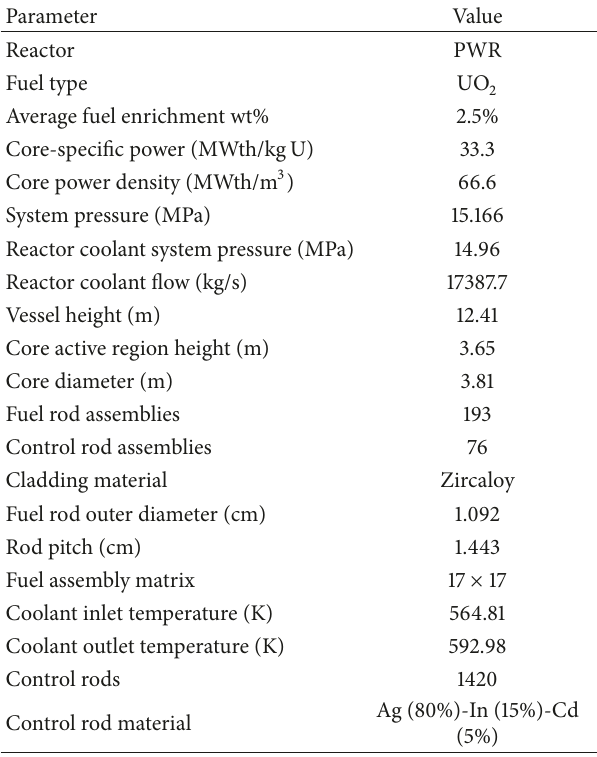
Table 1: Design parameters of 1000 MWe PWR [27,